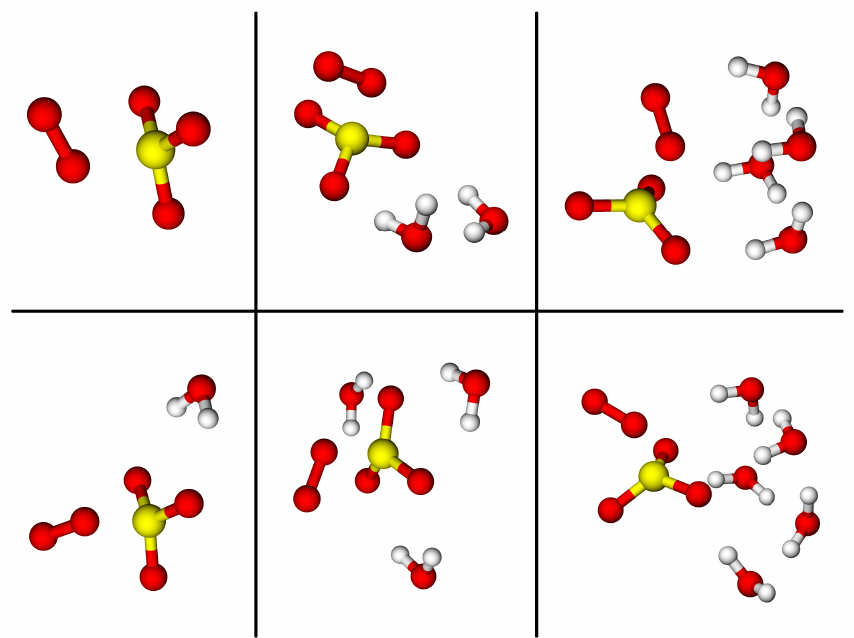
Fig. 7. Configuration of the product complexes SO − O 2 ( H 2 O ) n . The O 2 species is coordinated to the sulfur atom with S-O distances between 3 1.81 and 1.85 ˚A. The high concentration of atmospheric O 2 ensures a high population of these complexes. See also Sect.